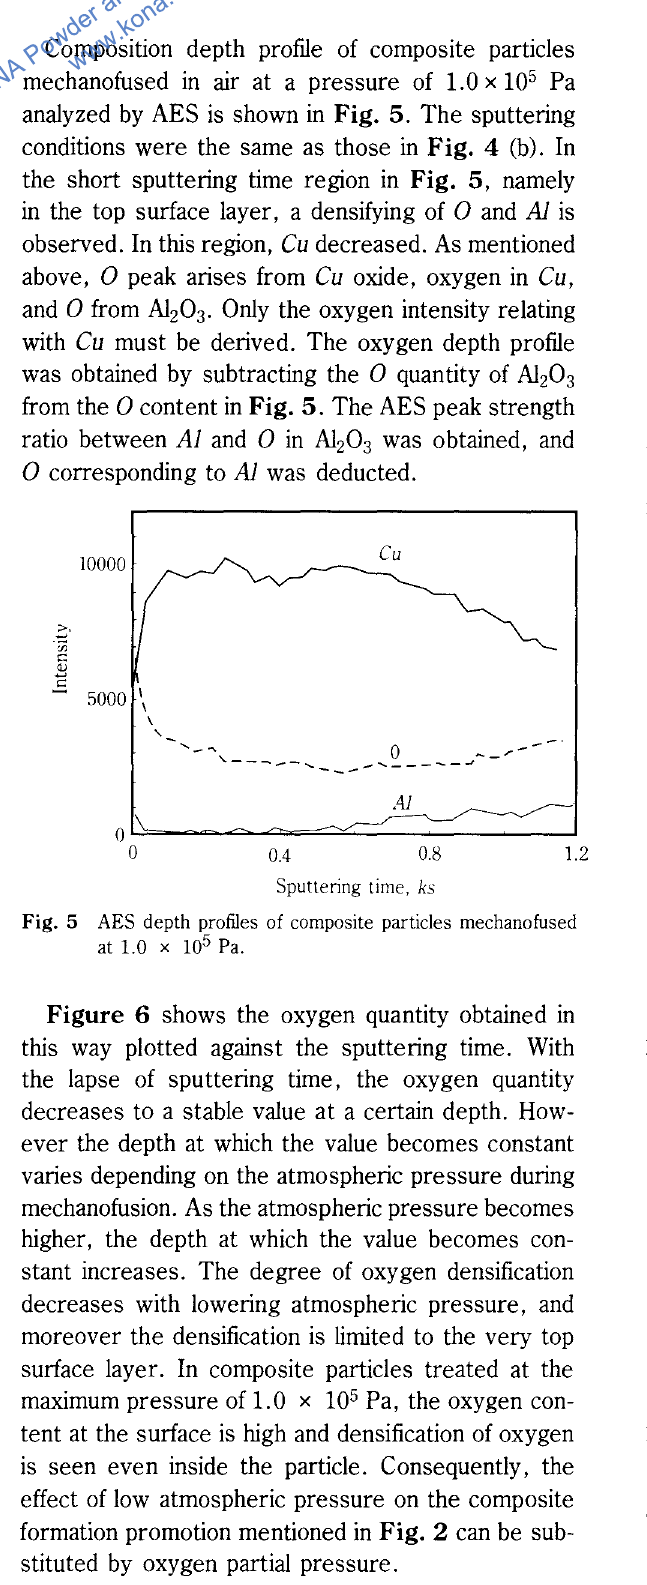
Fig. 5 AES depth profiles of composite particles mechanofused at 1.0 x 10 5 Pa.